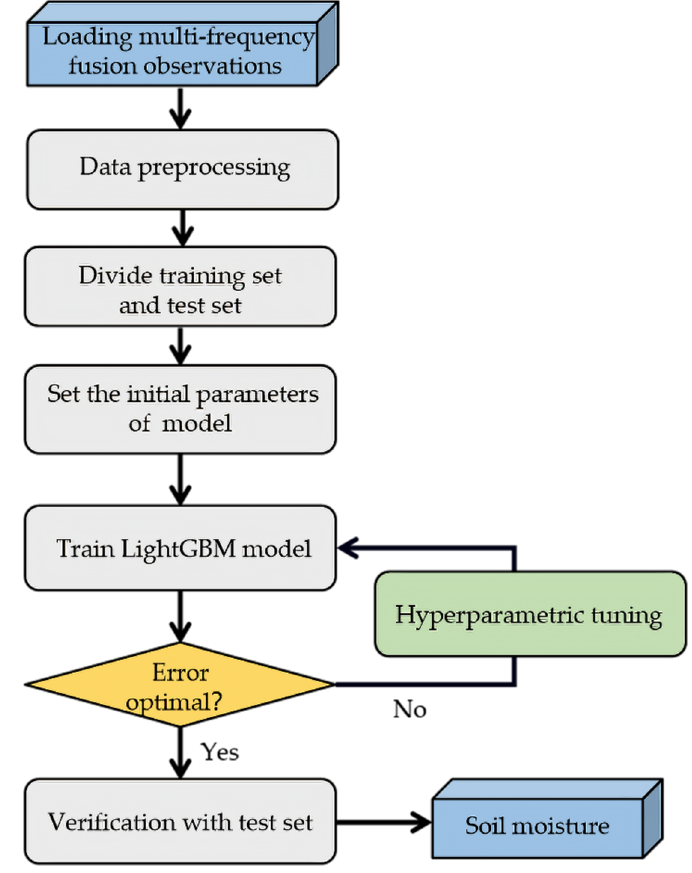
Figure 3. The framework of retrieval model.